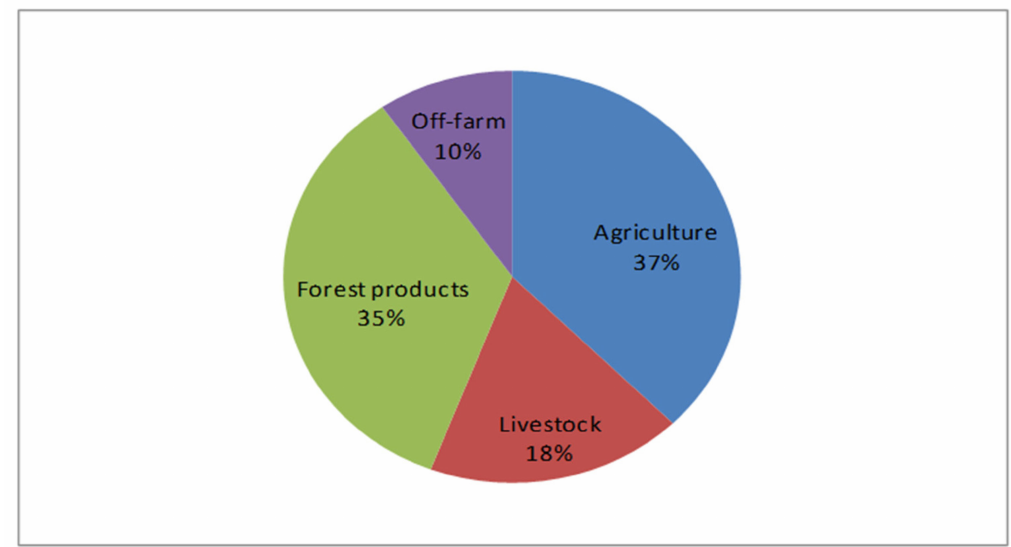
Figure 3. Percentages of occupational structure in the region (2019). Source: author’s field survey.